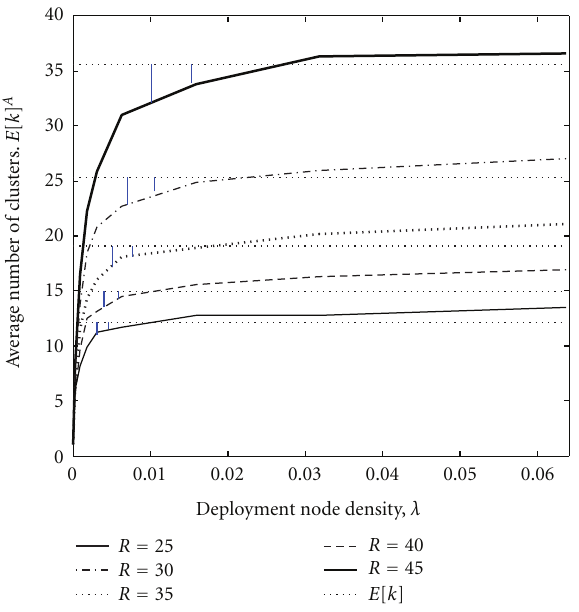
Figure 7: “ E [ k ] A versus λ ” for di ff erent R : 100m radius circular deployment